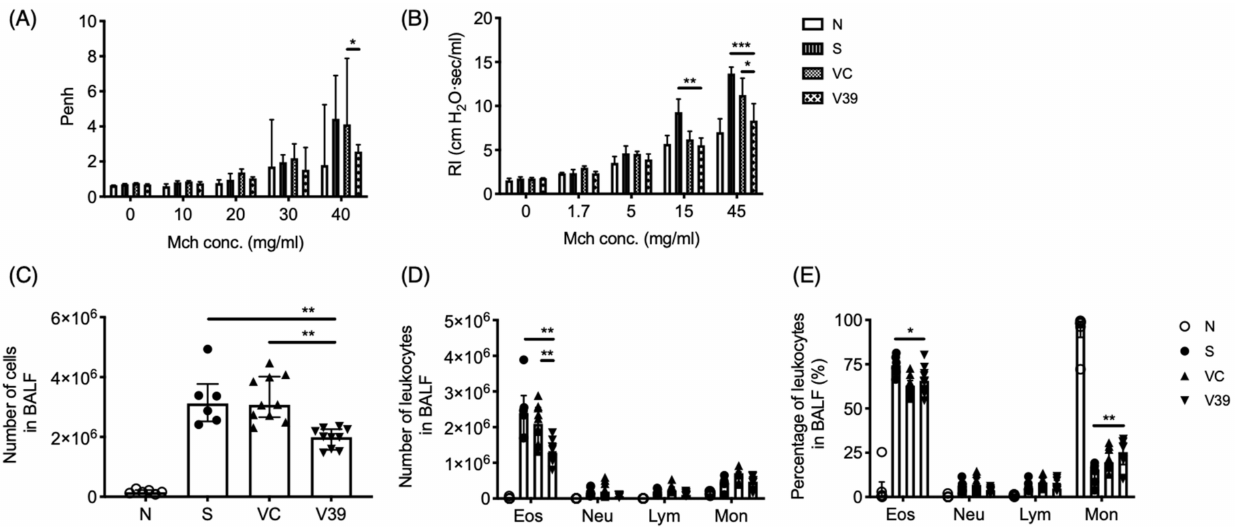
Figure 2. Exogenous expression of CD39 suppressed asthmatic airway inflammation. After the last OVA exposure, several cardinal features were analyzed. Airway hyperresponsiveness were determined by ( A ) Whole Body Plethysmography and ( B ) Resistance and Compliance (the difference was calculated by two-way ANOVA followed by Bonferroni test). Leukocyte infiltration in BALF was determined in ( C ) total cell numbers and differential leukocyte populations were performed by ( D ) the cell numbers and ( E ) the proportions. Data are presented as median with interquartile range (4–8 mice for Penh; 9–12 mice for RI; * p < 0.05, ** p < 0.01, *** p < 0.001 in the comparison of V39 with S or